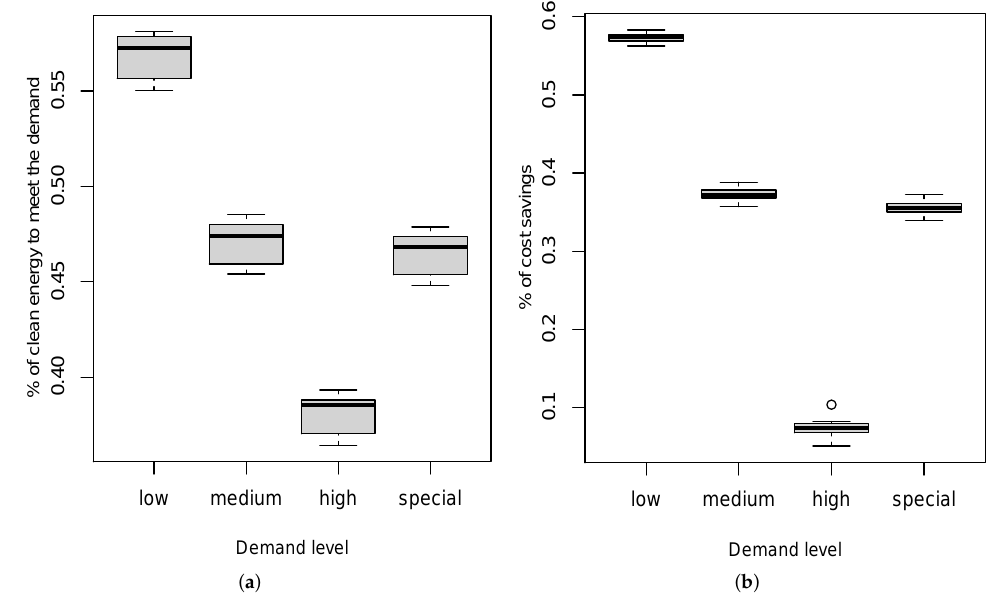
Figure 2. Sensitivity of the model to changes in demand. ( a ) Percentage of renewable energy to meet the demand for each experimental demand level. ( b ) Cost savings comparison for each level of demand using the same installed capacity.